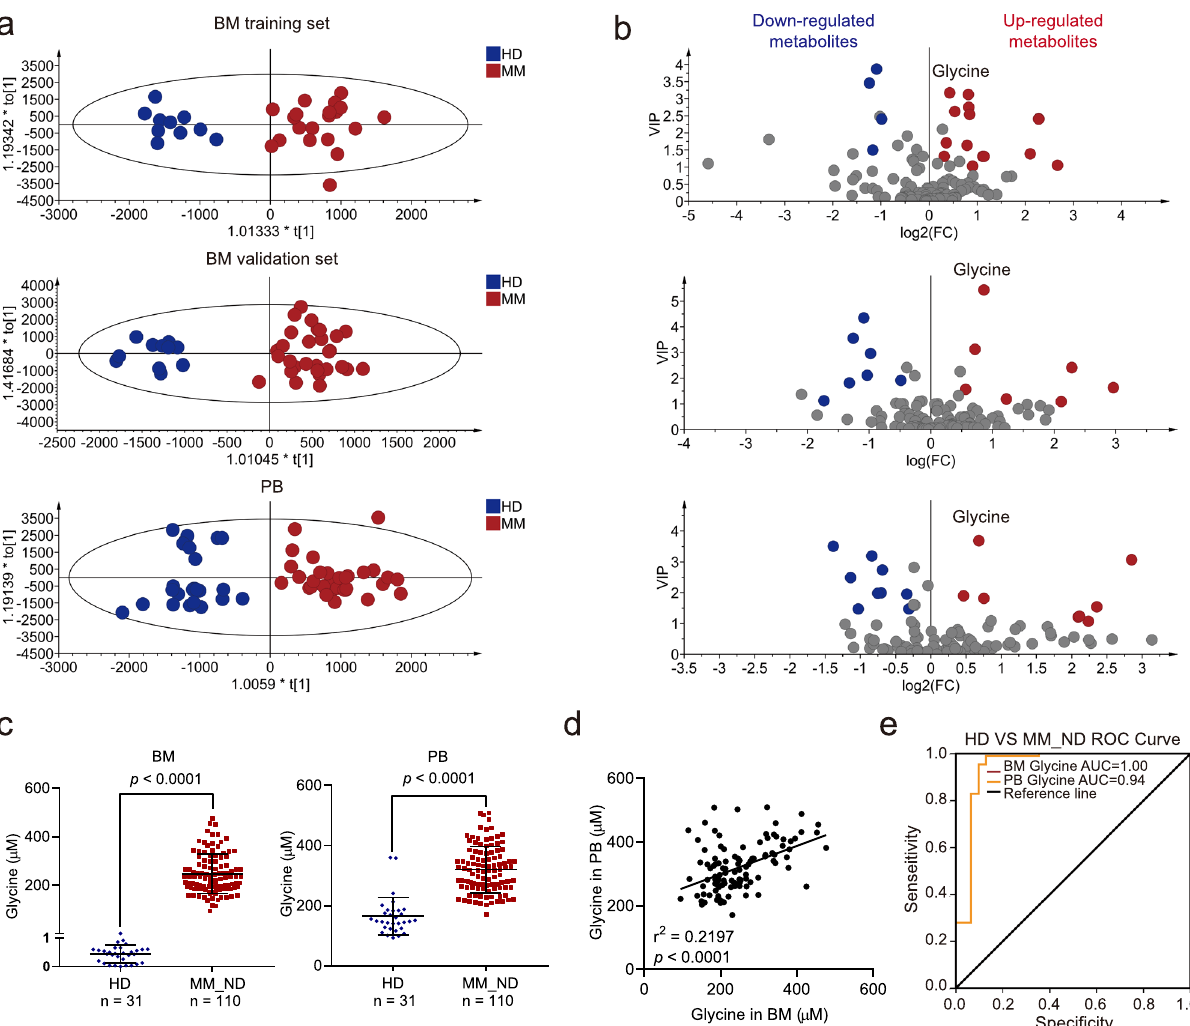
Fig. 1 Glycine is elevated in the BM microenvironment and linked to poor prognosis in MM. a , b (a) Plots of OPLS-DA scores for the BM liquid and PB plasma derived from MM patients and HDs (BM-training set: n = 10 in HD group, n = 20 in MM group; BM-validation set: n = 11 in HD group, n = 30 in MM group; PB: n = 26 in HD group, n = 31 in MM group), and (b) differential metabolites in all sets based on VIP, FC, and p -value (MetaboAnalyst 5.0 software with unpaired two-sided t -test). c Left: targeted metabolomics assays of glycine in the BM liquid derived from HDs ( n = 31) and newly diagnosed MM patients ( n = 110); Right: targeted metabolomics assays of glycine in the PB plasma derived from HDs ( n = 31) and newly diagnosed MM patients ( n = 110). Results represent means ± SD; A unpaired two-sided t -test was applied. d The correlation of glycine concentrations from the BM liquid and PB plasma ( n = 110; two- sided Pearson correlation analysis). e ROC curves drawn based on glycine concentrations using subjects derived from HDs and newly diagnosed MM patients ( n = 110). Source data are provided as a Source Data fi